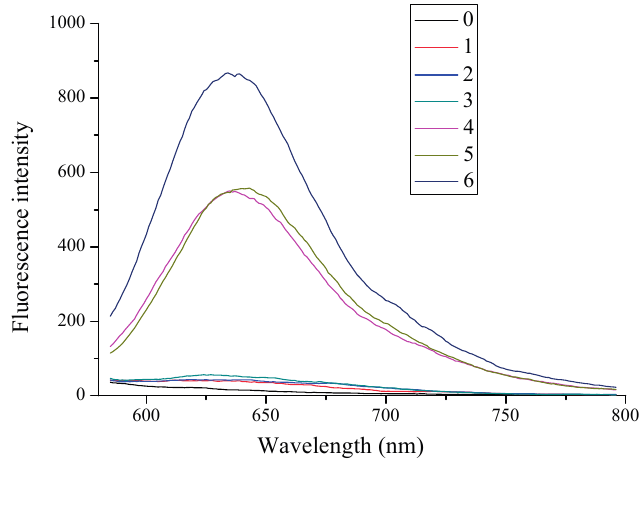
Figure 1. Fluorescence spectra of quinaldine red. Curve 0, quinaldine red (4 × 10 − 6 mol·L − 1 ); Curves 1–6, quinaldine red (4 × 10 − 6 mol·L − 1 ) + corresponding oligomer (4 × 10 − 6 mol·L − 1